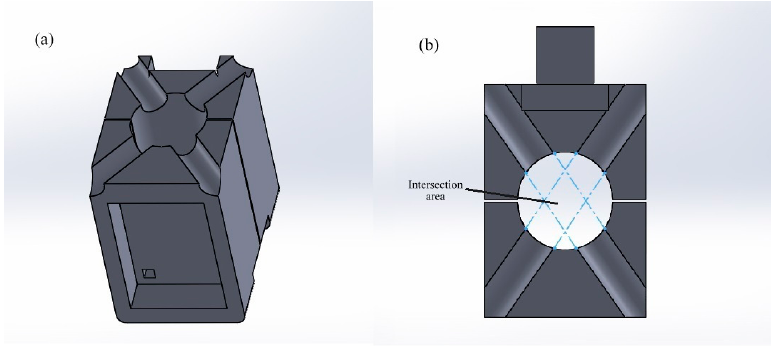
Figure 2. Designs of the sensor casings: ( a ) isometric view and ( b ) top view.